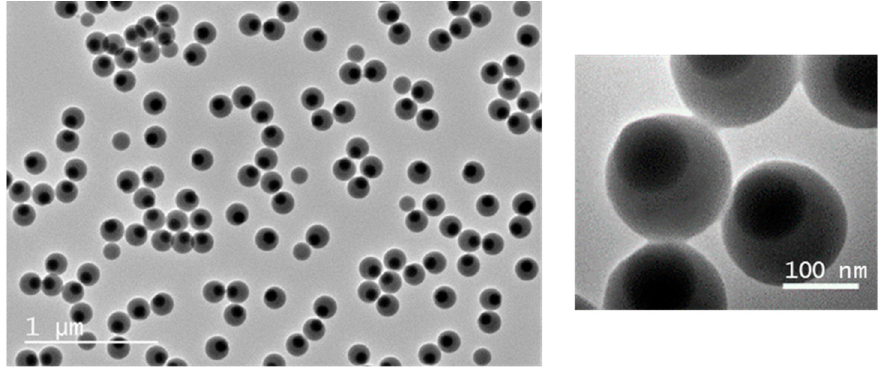
Figure 5. TEM images of silica/PS monopods (Table 1, entry #1.3) after two sorting cycles by cen- trifugation/redispersion (2000 g; 15